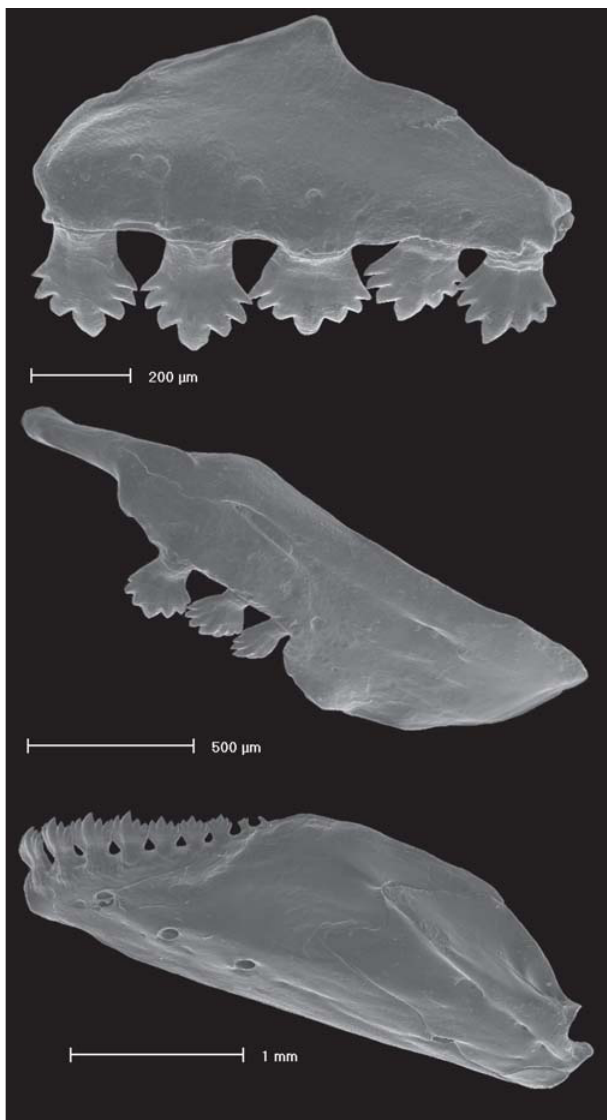
Fig. 15. Dentition of Odontostilbe ecuadorensis , KU 13524, male 43.5 mm SL. SEM photograph of left side premaxilla (top), maxilla (middle), and dentary